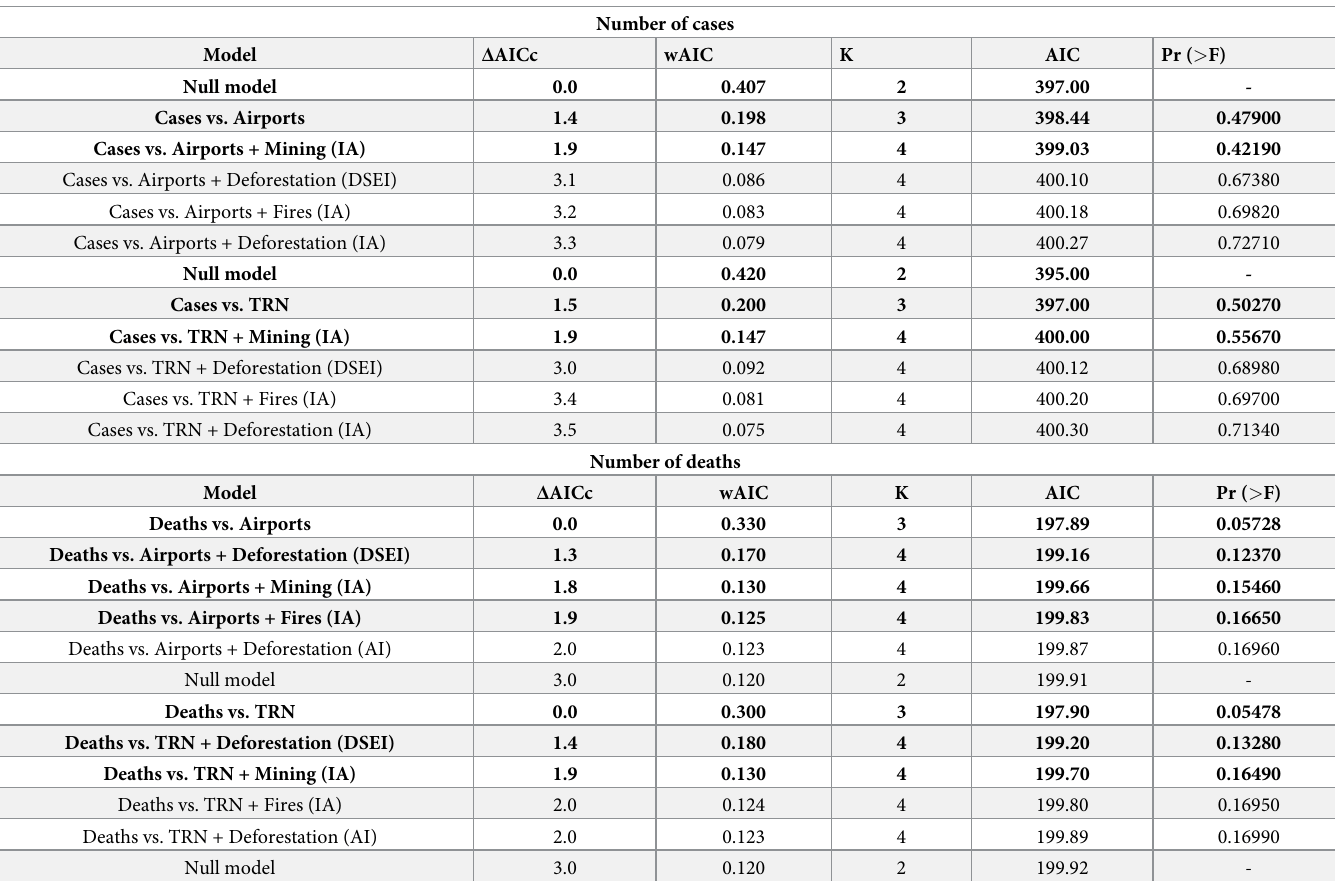
Table 1. The models used to test the effect of the number of airports, total road network (TRN), deforested area within the DSEI, deforested area within indigenous areas (IAs) of the DSEI, natural vegetation area converted into mining area within IA, and natural vegetation area converted into a burned area within IA on the number of COVID-19 cases and deaths among indigenous people in the DSEIs of the Brazil’s Legal Amazon